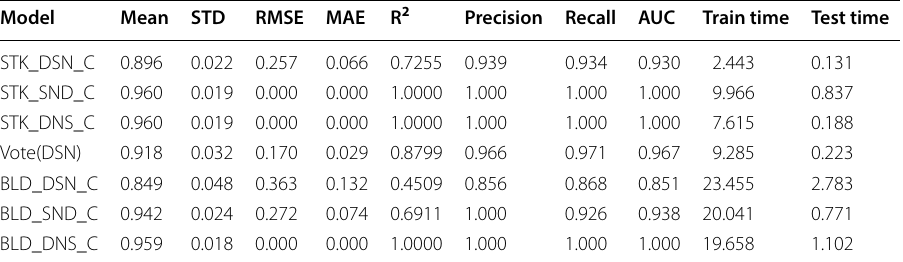
Table 19 Stacking and blending ensemble classifiers error metrics result over GSE dataset Model